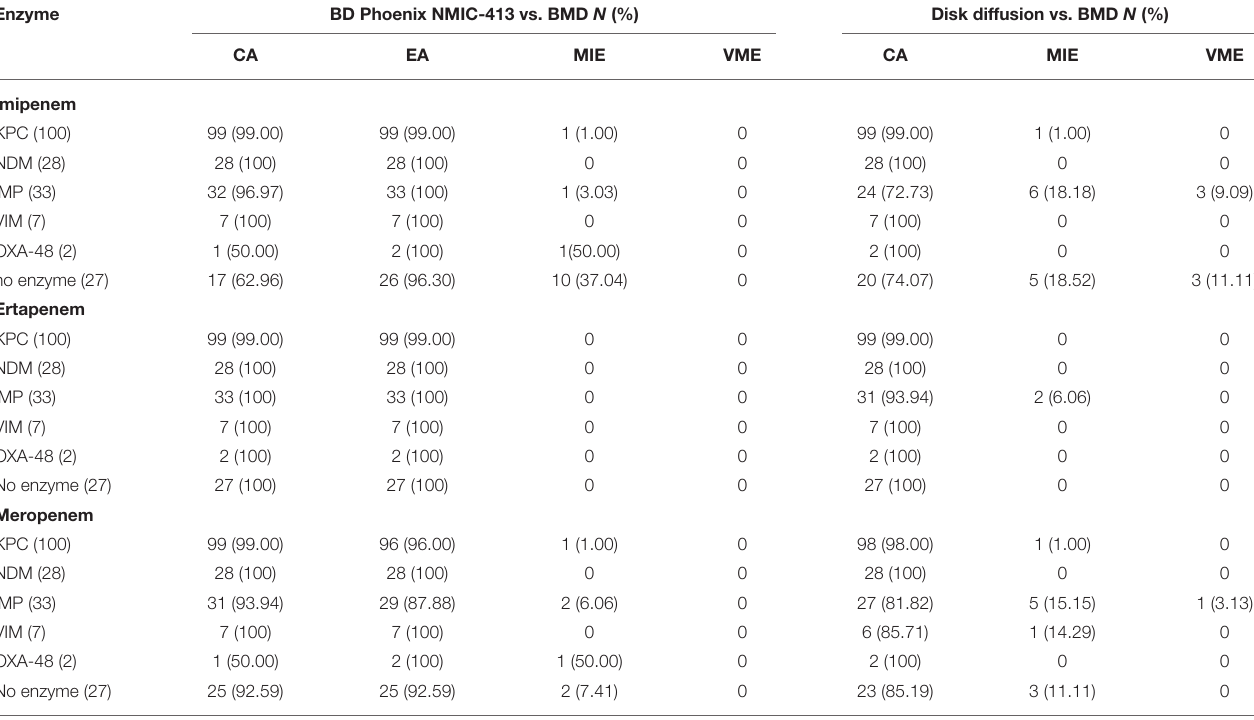
TABLE 3 | Performance of the BD Phoenix NMIC-413 and disk diffusion compared with BMD for 195 CREs. Enzyme BD Phoenix NMIC-413 vs. BMD N (%) Disk diffusion vs. BMD N